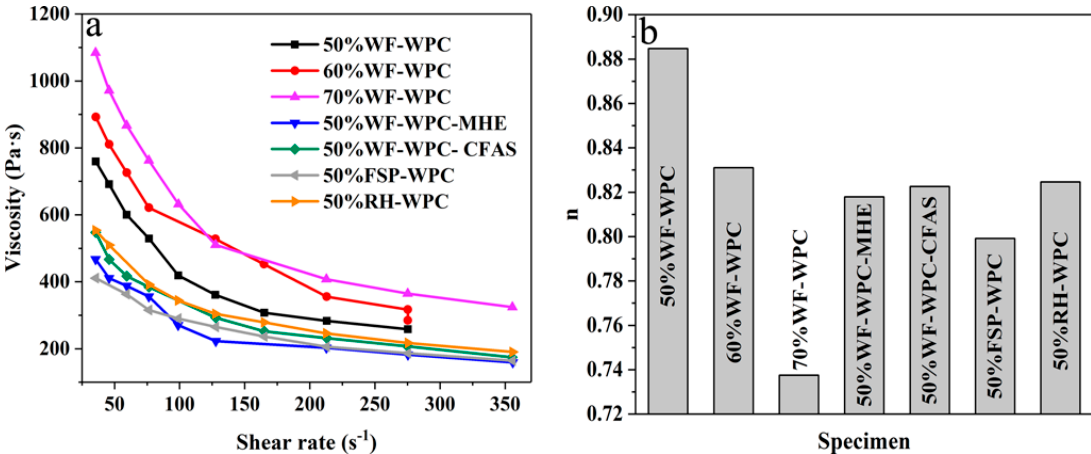
Figure 6. The viscosity and non-Newtonian index ( n ) of WPCs: ( a ) viscosity–shear rate curve; ( b ) n .